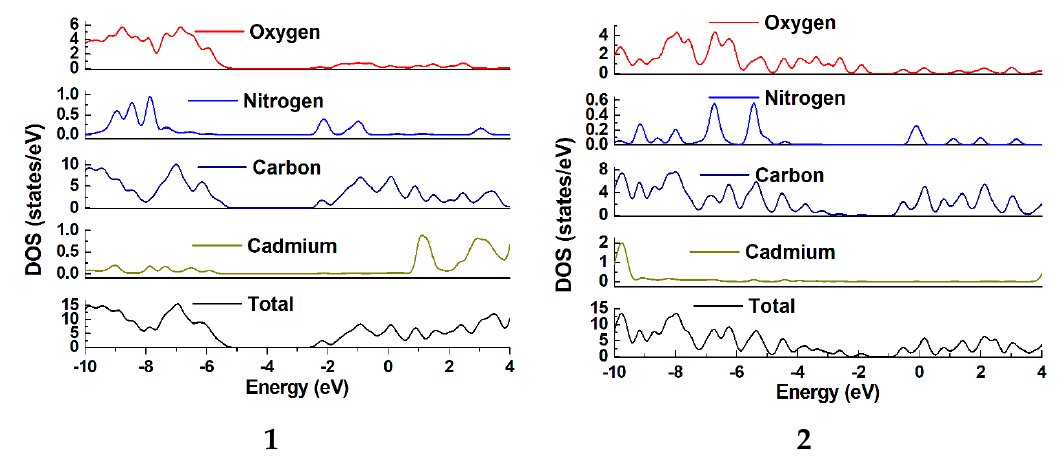
Figure 5. The DOS and partial DOS plots for CPs 1 and 2 .